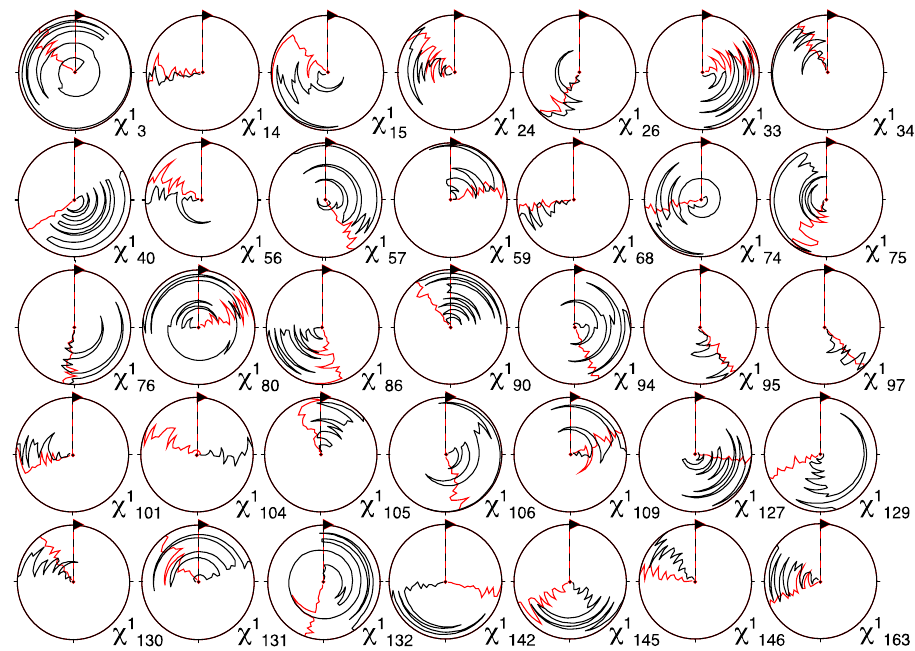
Figure 6. Circle plots of χ 1 angles of stereospecifically assigned methylene protons using the method presented ( red ). Shown are the residues for which the angle distributions were narrowed the most when compared with angles in the structures calculated from exact nuclear Overhauser enhancements (eNOEs) and J-couplings without stereospecific assignment ( black ). The 20 conformations with the lowest CYANA target function were used. A similar plot depicting all residues is presented in Figure S3 in the Supporting Information.